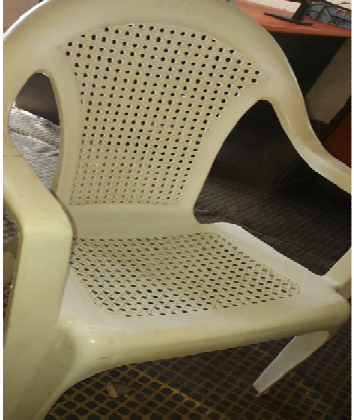
Figure 4. Alt-text: An empty white plastic chair.